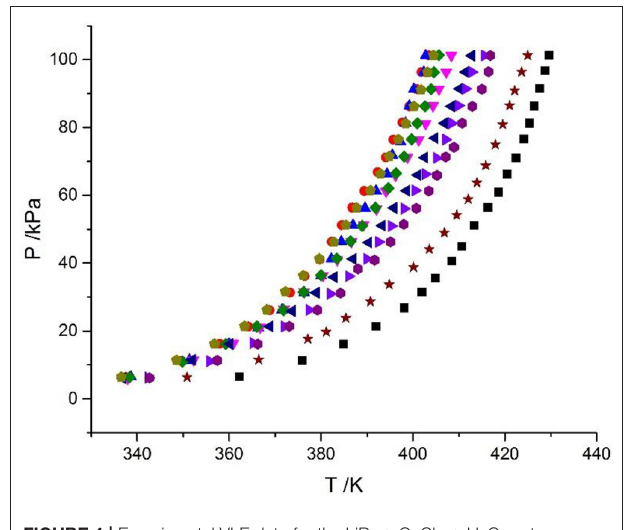
FIGURE 4 | Experimental VLE data for the LiBr + CaCl 2 + H 2 O system. Symbols ( , ma = 21.05 mol/kg, mb = 0 mol/kg; , ma = 1.5 mol/kg, mb = 8.5 mol/kg; , ma = 3.08 mol/kg, mb = 8.1 mol/kg; , ma = 4.12 mol/kg, mb = 7.1 mol/kg; , ma = 5.5 mol/kg, mb = 6.1 mol/kg; , ma = 7.1 mol/kg, mb = 4.7 mol/kg; , ma = 8.95 mol/kg, mb = 4.08 mol/kg; , ma = 11 mol/kg, mb = 3.3 mol/kg; , ma = 16.5 mol/kg, mb = 1.5 mol/kg; , ma = 0 mol/kg, mb = 8.91 mol/kg): experimental data (this work).